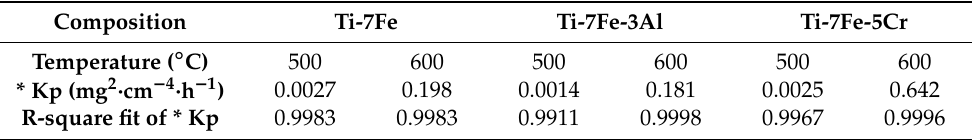
Table 6. Calculated oxidation rate constant Kp for di ff erent alloys and temperatures according to Monceau et al. [35] oxidation